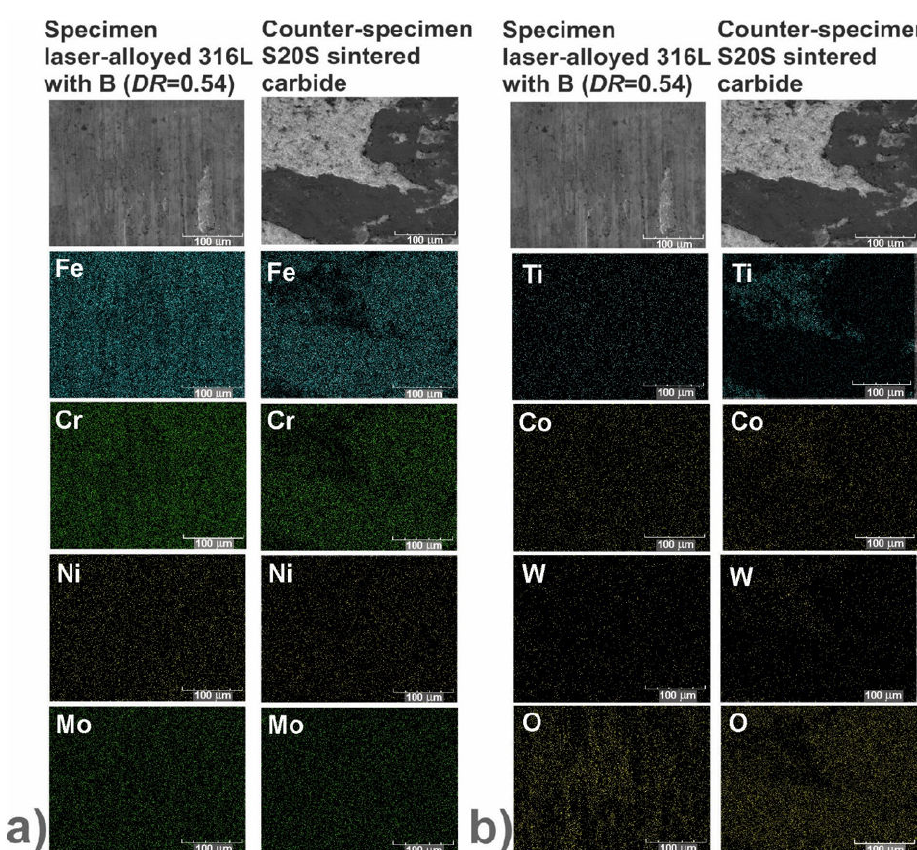
Figure 8. Worn surfaces of laser-borided specimen with a dilution ratio of 0.54 and counter-specimen (S20S sintered carbide). ( a ) EDS patterns of the elements characteristic of the specimen as well as ( b ) the counter-specimen, taking into account oxygen concentration. Two-hour wear test with the change of counter-specimen at every 0.5